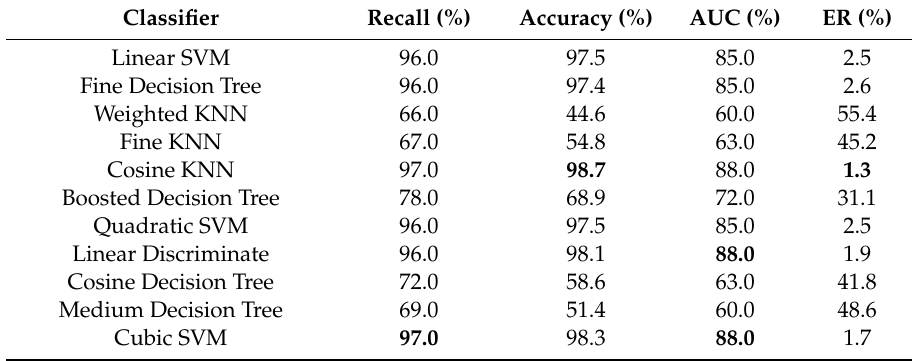
Table 5. Imbalanced data without feature fusion and optimization results on pre-trained network. Best values are shown in bold.